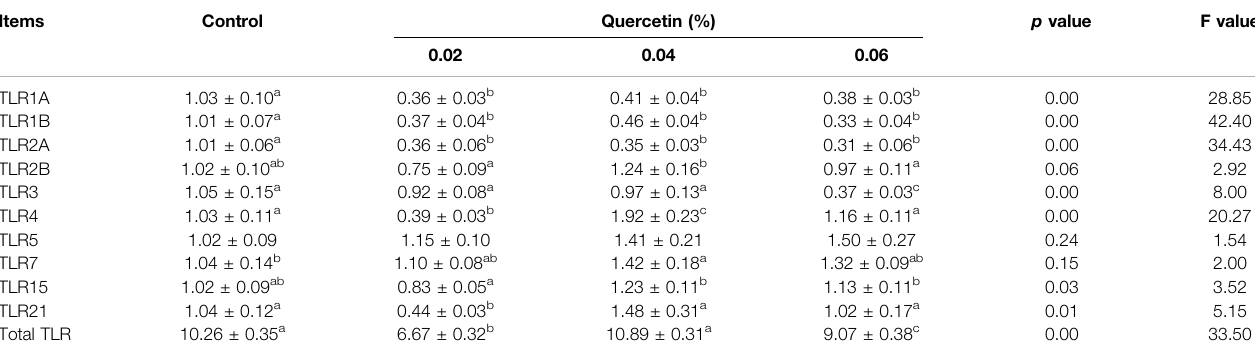
TABLE 9 | Effect of quercetin on the mRNA expression of Toll-like receptors in the ileum of AA broilers. Items Control